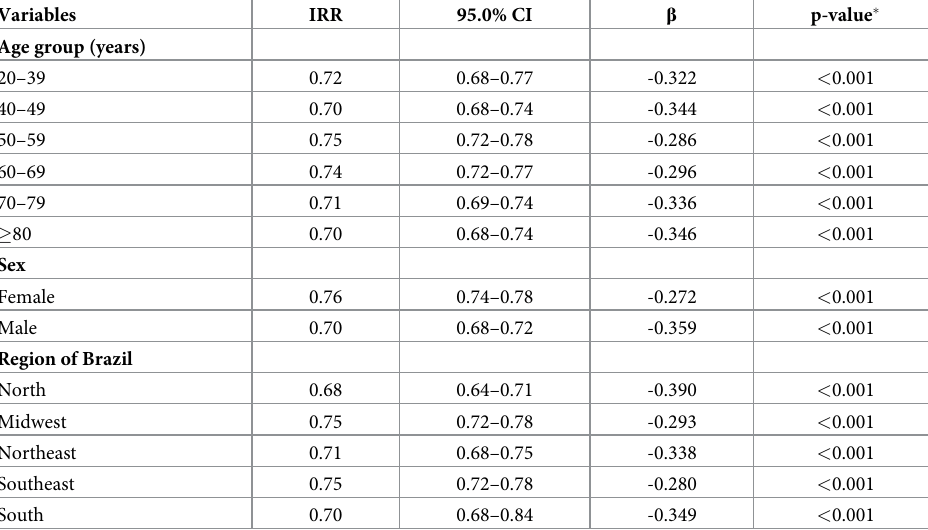
Table 6. Poisson multiple regression models of the impact of the coronavirus disease pandemic on the hospitali- zation rate for all types of chronic non-communicable diseases in Brazil according to subgroups by age group, sex, and region of